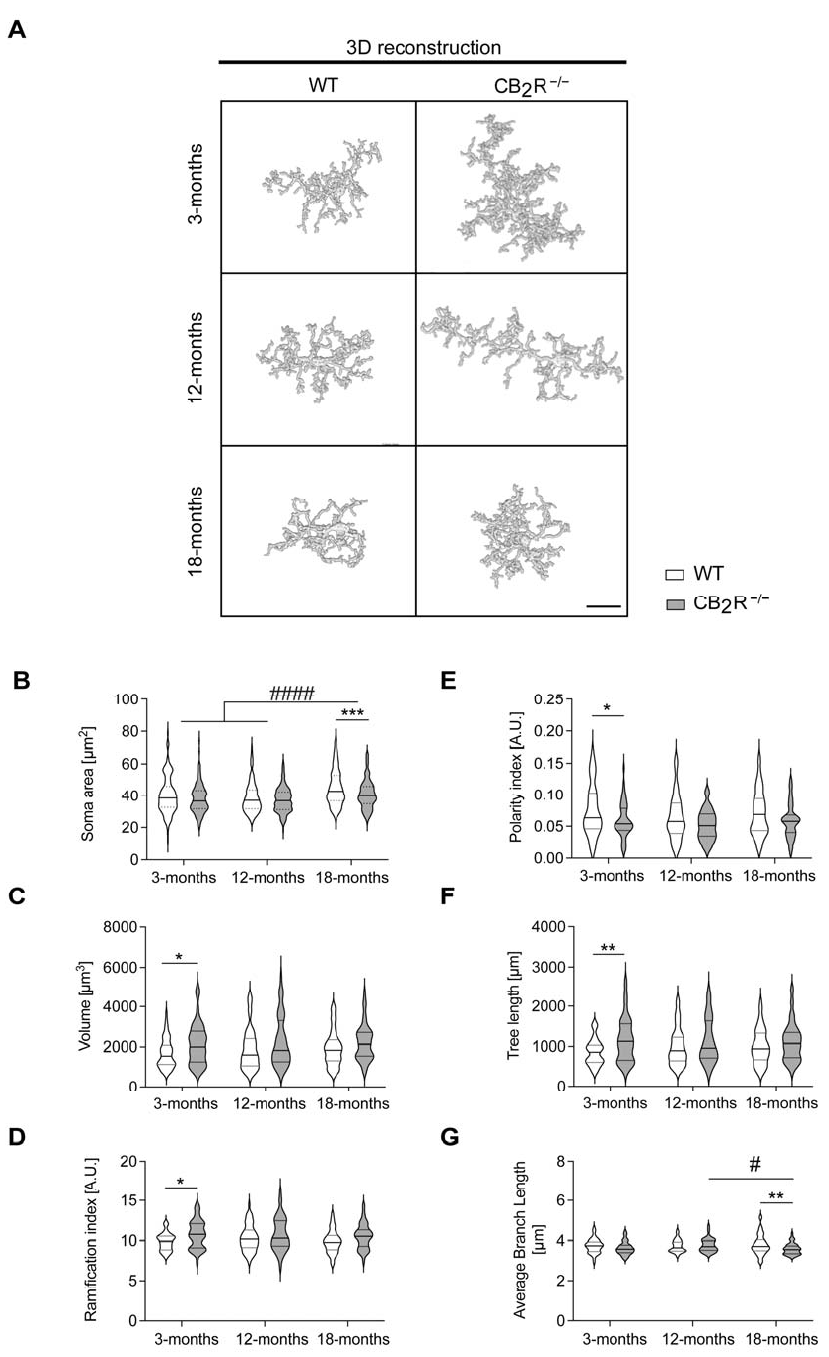
Figure 7. CB 2 R deletion changes hippocampal microglial morphology. Representative reconstruction images with a scale bar of 20 µ m ( A ). Microglia morphology was analyzed by measuring the soma size ( B ), volume ( C ), ramification index ( D ), polarity index ( E ), tree length ( F ), and average branch length ( G ). Microglia morphology differs between CB 2 R − / − mice and WT mice. Soma size increased with age in both WT and CB 2 R − / − microglia. Data displayed as median (full line) with 25 and 75 percentiles (dotted lines). WT mice—white circle; CB 2 R − / − mice—grey circles. N = 6 mice/genotype/age group. Two-way ANOVA followed by Sidak’s multiple comparisons with * p < 0.05, ** p < 0.01, *** p < 0.001, significance between genotypes within the same age group, # p < 0.05, #### p < 0.0001 significance between age groups within the same